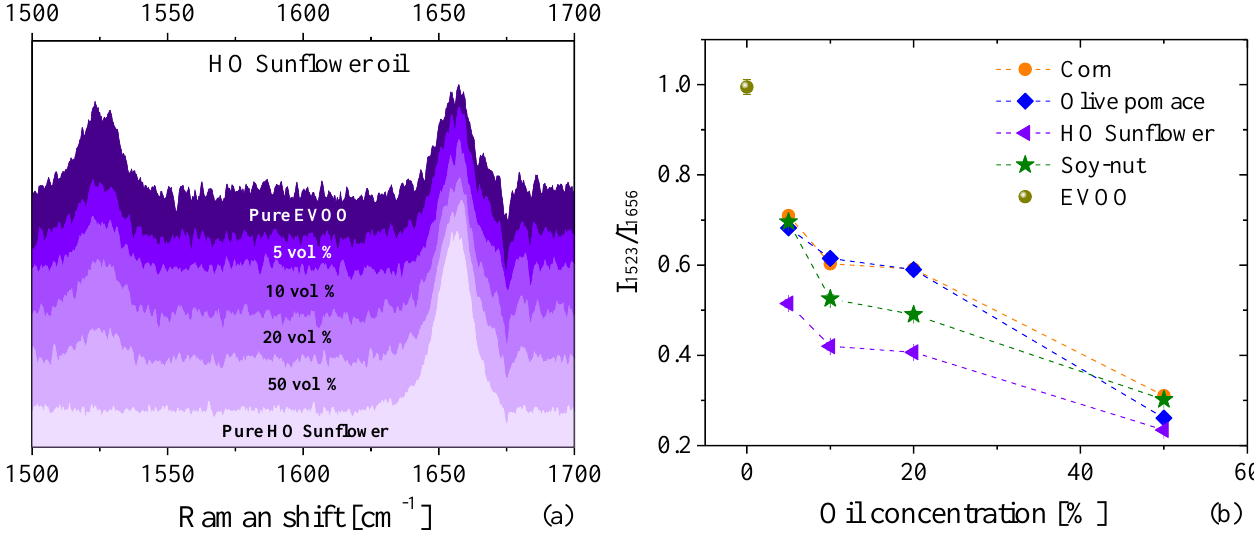
Figure 3. ( a ) Raman spectra of EVOO adulterated with different concentrations of high oleic sunflower oil. ( b ) Intensity ratio of the carotenoid peak (1523 cm −1 , I 1523 ) to the C=C stretching peak (1656 cm −1 , I 1656 ) as a function of the adulterant oil concentration.